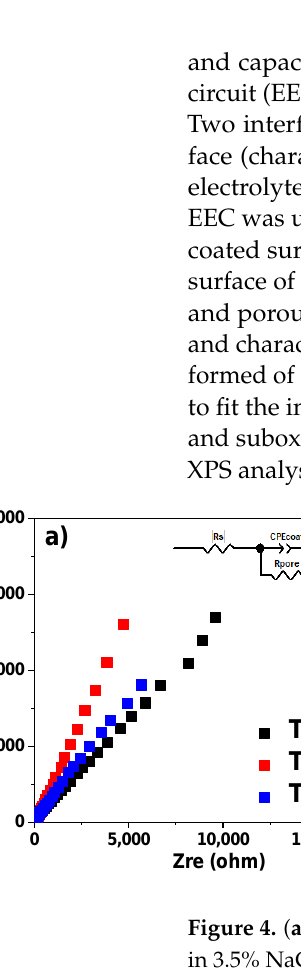
Table 3. The fitting results of EIS data for the investigated samples after 1 h immersion in 3.5% NaCl.